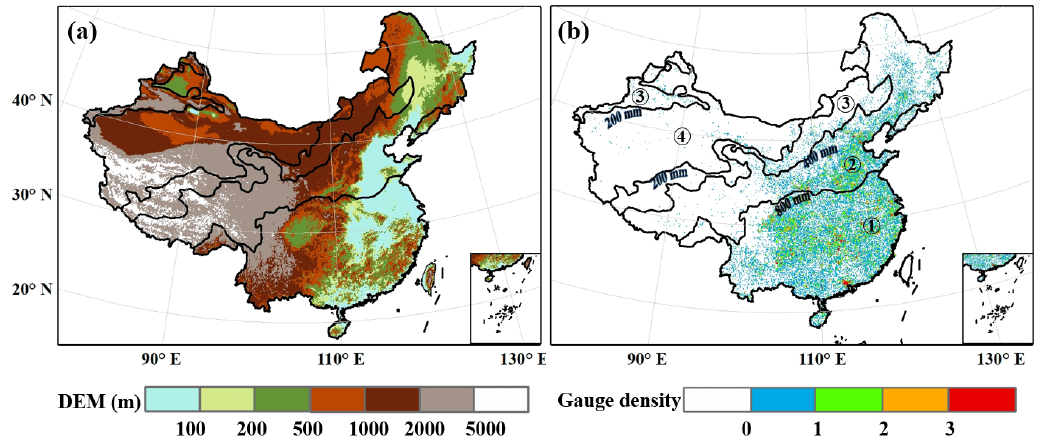
Figure 1. ( a ) Topographic map of China; ( b ) Spatial distributions of rain gauge stations and the climate regions over Mainland China.